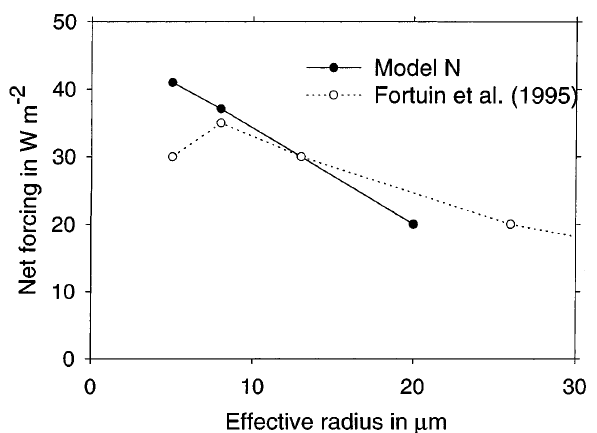
Fig. 7. Net forcing versus e(cid:128)ective particle radius for fixed ice water path (IWP) and for 100% contrail cover with parameters as in case (a). Results from the present computations (model N, solid curve with solid dots ), results from Fortuin et al. (1995) for IWP (cid:136) 4 g m ) 2 ( dashed curve with open